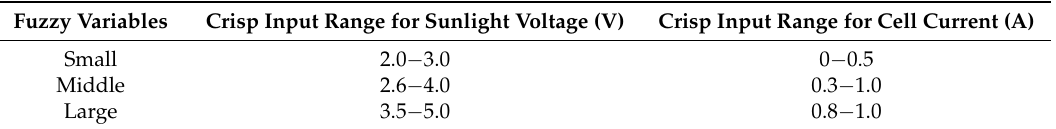
Table 3. Membership functions for the input